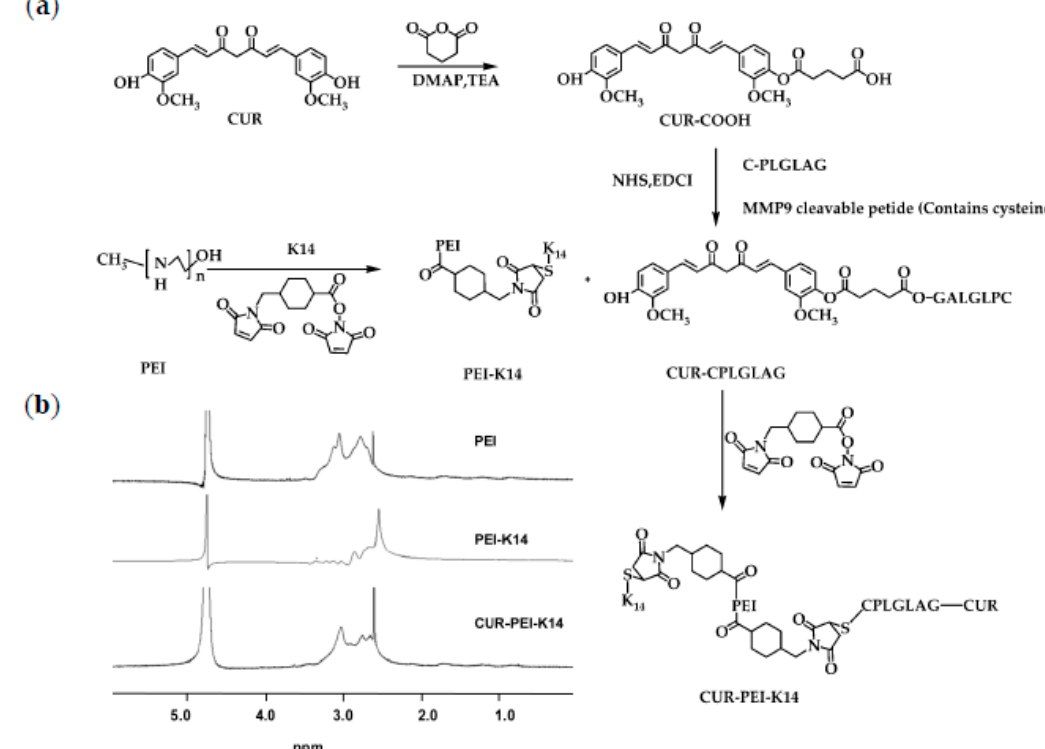
Figure 2. ( a ) Synthetic scheme of CUR-PEI-K14. ( b ) Representative 1 H-NMR spectra of PEI, PEI-K14, and CUR-PEI-K14 in D 2 O at room